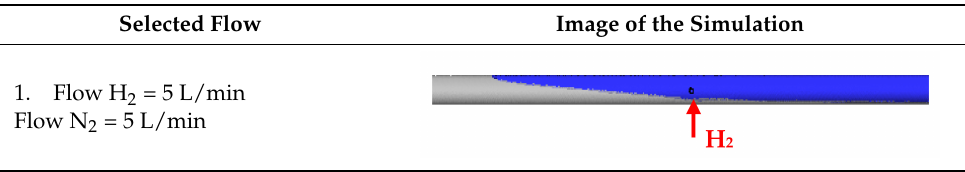
Table 4. Simulation results of basic geometry (blue—H 2 profile, grey—N 2